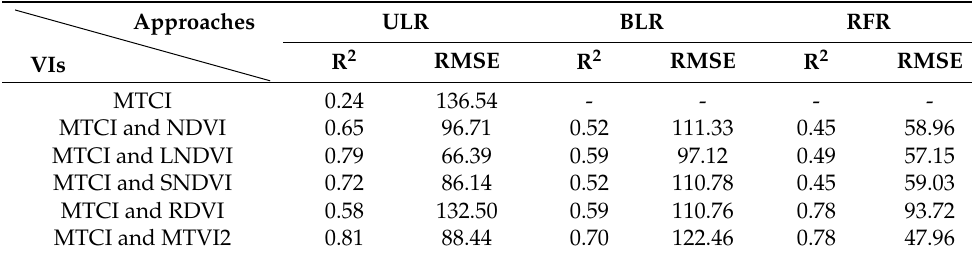
Figure 11. Accuracy of CCC retrieval for soybean crops using RFR and MERIS imagery: ( b ) MTCI and NDVI; ( c ) MTCI and LNDVI; ( d ) MTCI and SNDVI; ( e ) MTCI and RDVI; ( f ) MTCI and MTVI2. The performance of a single MTCI in a linear regression model is displayed in ( a ) for comparison.